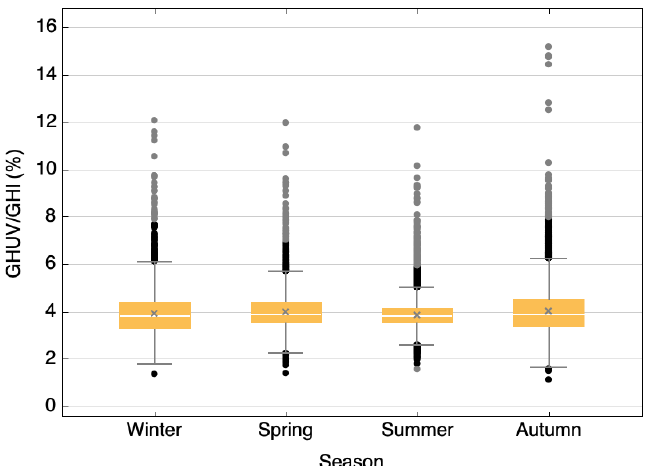
Figure 8. Boxplot of the GHUV/GHI seasonal averages based on the 10 min